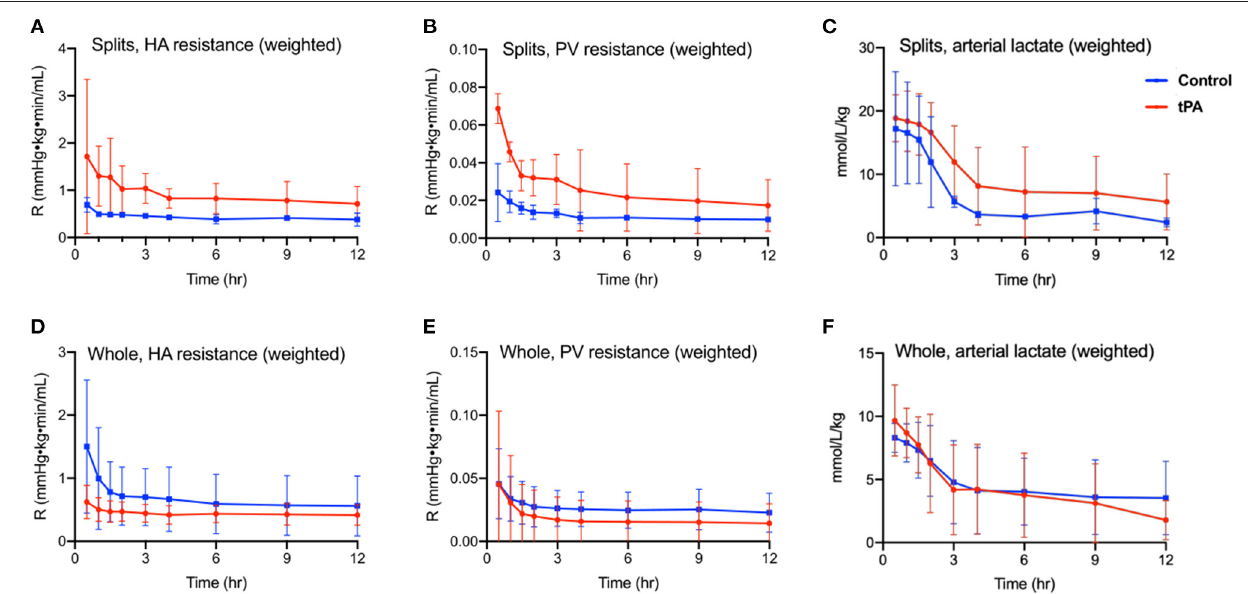
FIGURE 1 | Perfusion metrics of 12h normothermic machine perfusion (NMP). Split liver model comparing (A) hepatic artery resistance (defined as hepatic artery pressure divided by hepatic artery flow rate, adjusted for liver weight), (B) portal vein resistance (defined as portal vein pressure divided by portal vein flow rate, adjusted for liver weight), and (C) arterial (inflow) lactate (adjusted for liver weight) showed no statistically significant differences between tPA lobes (red) and control lobes (blue) on two-way ANOVA testing. Whole liver model comparing (D) hepatic artery resistance, (E) portal vein resistance, and (F) arterial (inflow) lactate (adjusted for liver weight) showed no statistically significant differences between tPA whole livers (red) and control livers (blue) on two-way ANOVA testing. HA, hepatic artery. PV, portal vein. R, intrahepatic resistance. Error bars indicate standard deviations. Significance level p ≤ 0.05.